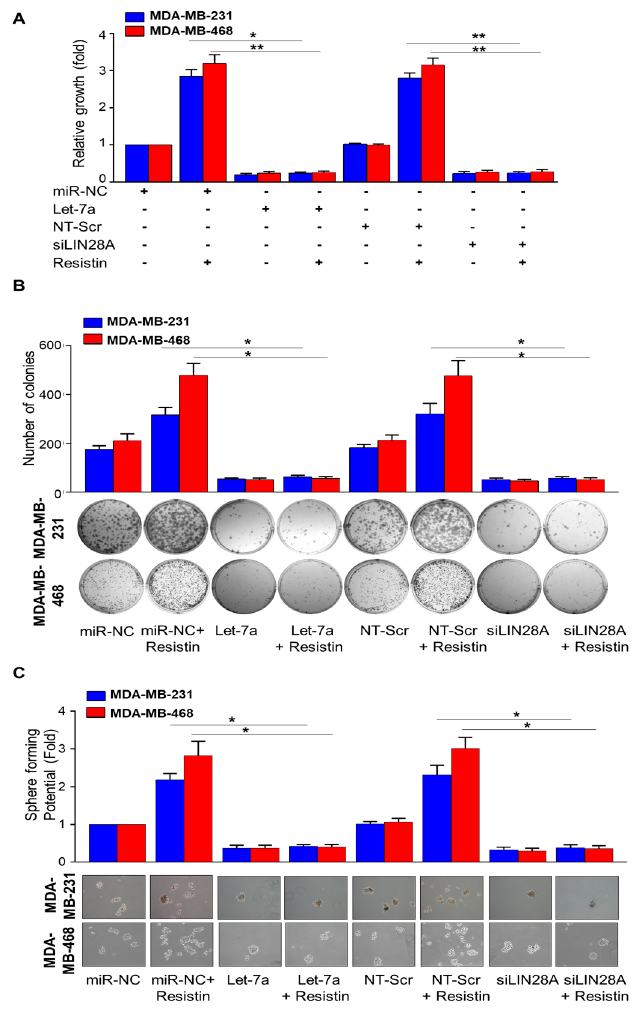
Figure 3. LIN28A/Let-7-miR axis mediates resistin-induced growth and stemness of breast cancer cells. ( A ) MDA-MB-231 and MDA-MB-468 BC cells were transfected with NT-Scr/miR Control (miR- NC) or siLin28A/Let-7a mimics and treated with resistin (20 ng/mL). After 24 h, cells were tryp- sinized and seeded in 96-well plates. Growth was measured after 96 h by WST-1 assay. ( B ) BC cells were transfected with NT-Scr/miR-NC or siLin28A/Let-7a mimic. After transfection, BC cells were treated with resistin for 24 h, trypsinized, counted, and seeded at low density (1 × 10 3 cells per well) in 6-well plates. After two weeks, colonies were stained with crystal violet and visualized and pho- tographed using the imaging system. ( C ) BC cells transfected with Let-7a or LIN28A, treated with resistin, and seeded at low density (1 × 10 3 ) in ultra-low attachment plates and allowed to grow for two weeks in stem cell culture medium. Images were taken under a light microscope at 200× mag- nification, and the number of spheres was counted manually. Data represents mean ± S.D. n = 3, * p < 0.05, ** p < 0.001. 3.4. Let-7a Downregulation Caused by Resistin Treatment Is Associated with Upregulation of STAT3 and IL-6 in Breast Cancer Cells Having observed the involvement of Let-7a in resistin-induced growth, survival, and stemness potential of BC cells, we next sought out to examine the specific target(s) of Let- 7a in BC cells. For this, we analyzed the expression of genes involved in cell growth, sur- vival, and stemness by RT-PCR analyses using focused arrays in resistin and/or Let-7 mimic-treated BC cells. We observed that resistin altered the expression of several genes associated with cell survival, cell cycle, and stemness in BC cells, and pre-treatment with Let-7a mimics abrogated resistin-induced changes in gene expression (Figure 4A). Next,